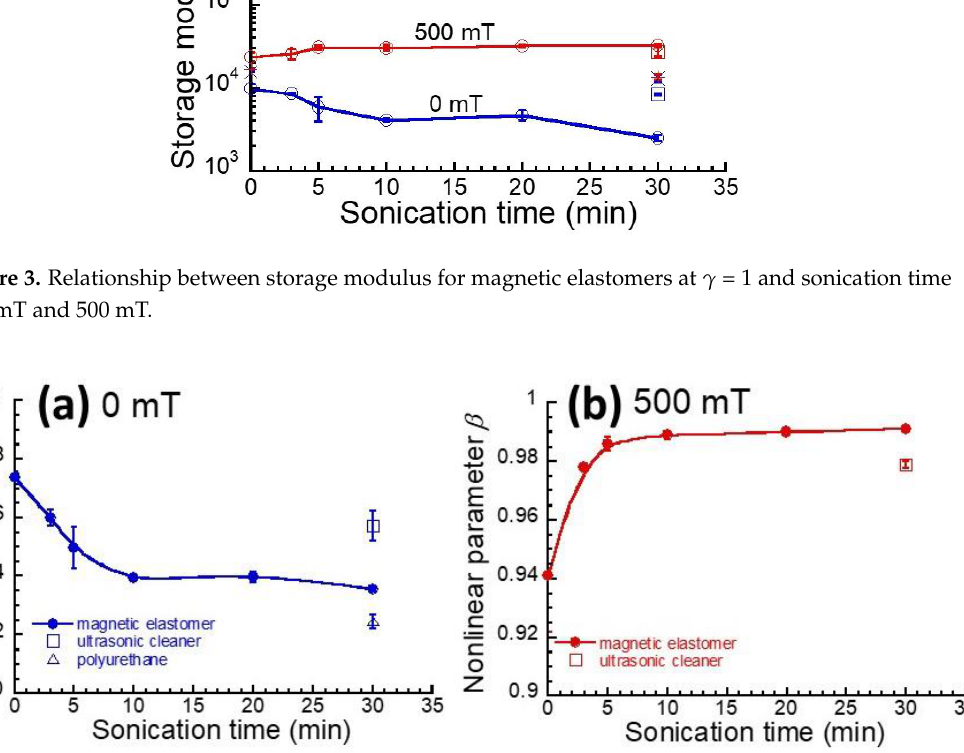
Figure 4. Relationship between nonlinear parameter defined by Equation (1) and sonication time for magnetic elastomers, ( a ) 0 mT, ( b ) 500 mT.